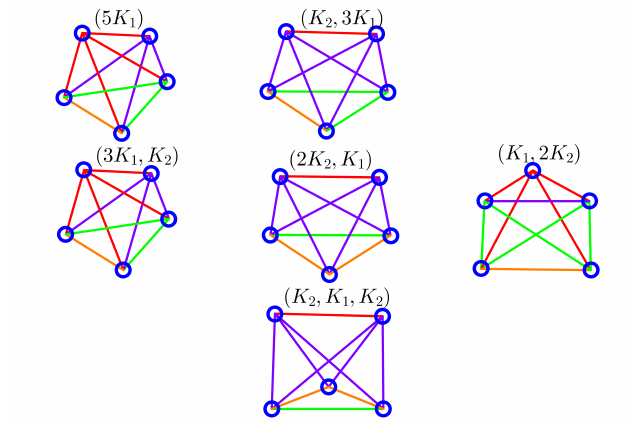
Fig. 1. 4-colorings of edges of K 5 without rainbow K